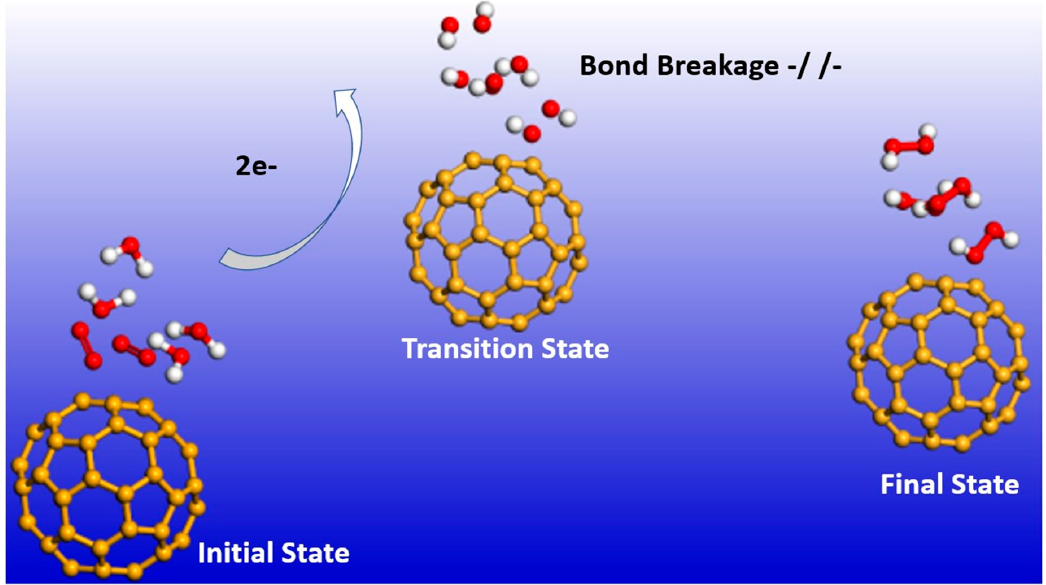
Figure 6. Doubly-charged anionic transition state optimization for C 60 -6. The red, white and gold spheres represent O 2 , H 2 and C 60 (catalyst), respectively. Note that, here as well, the bonds are broken in the transition state.